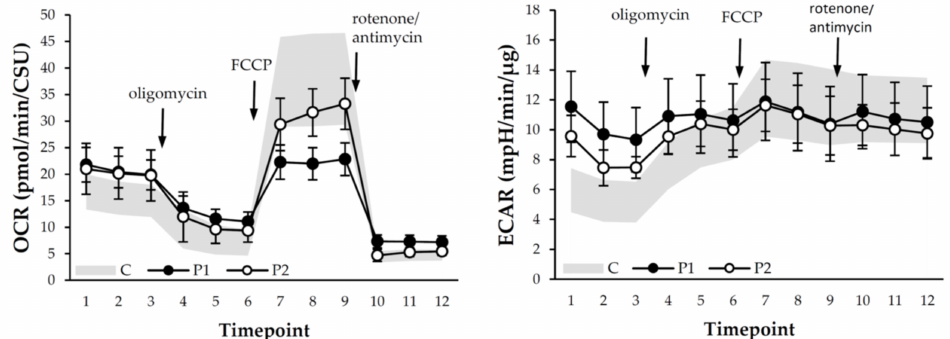
Figure 3. Graphical representation of the oxygen consumption rate (OCR) and extracellular acidifica- tion rate (ECAR) at baseline and after challenges with oligomycin, FCCP, and a rotenone antimycin A mix, respectively. OCR is normalized against citrate synthase units (CSU). Depicted are the mean results ± standard deviation ( n = 5 for P1, n = 6 for P2). Filled circles represent the results of P1, unfilled circles the results of P2. The results of the control group ( n = 20) are depicted in